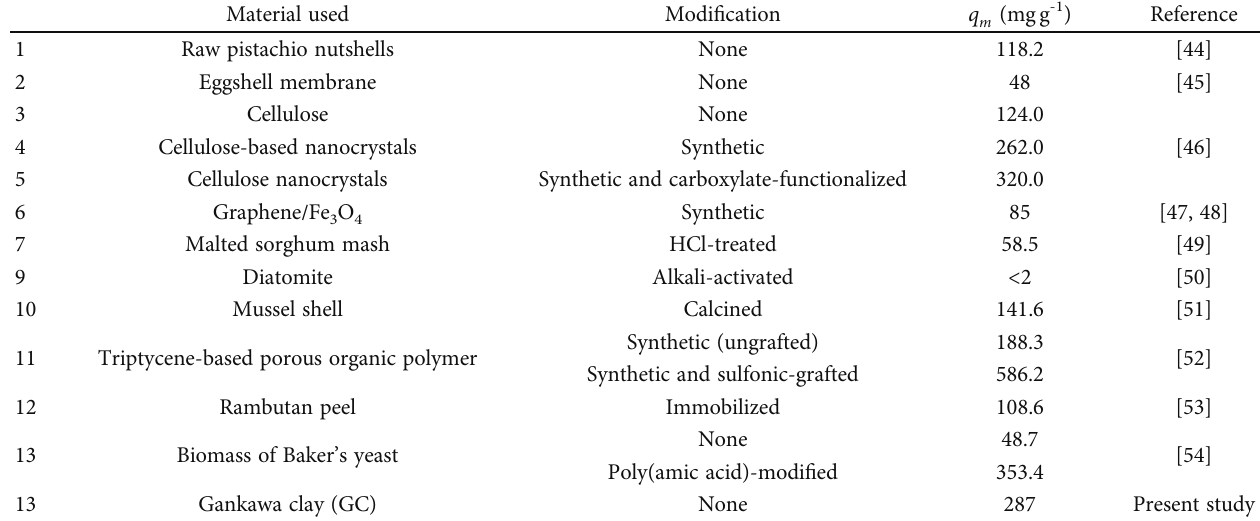
Table 5: Comparison of the adsorption capacity of GC with other reported natural, modi fi ed, and synthetic adsorbents. Material